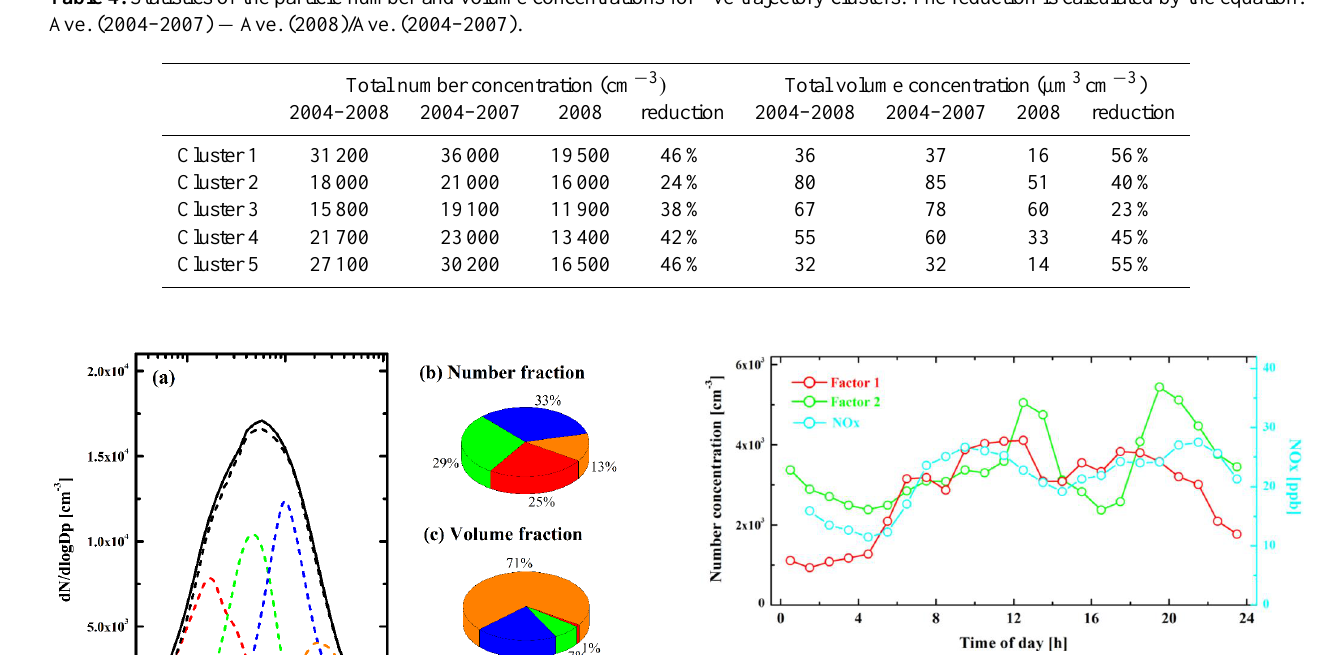
Table 4. Statistics of the particle number and volume concentrations for five trajectory clusters. The reduction is calculated by the equation: